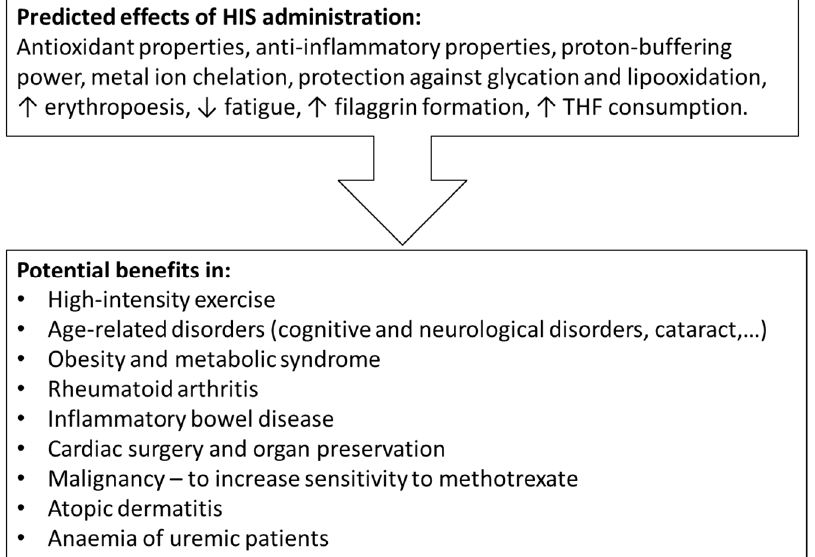
Figure 7. Predicted effects and potential benefits of HIS-containing supplements.